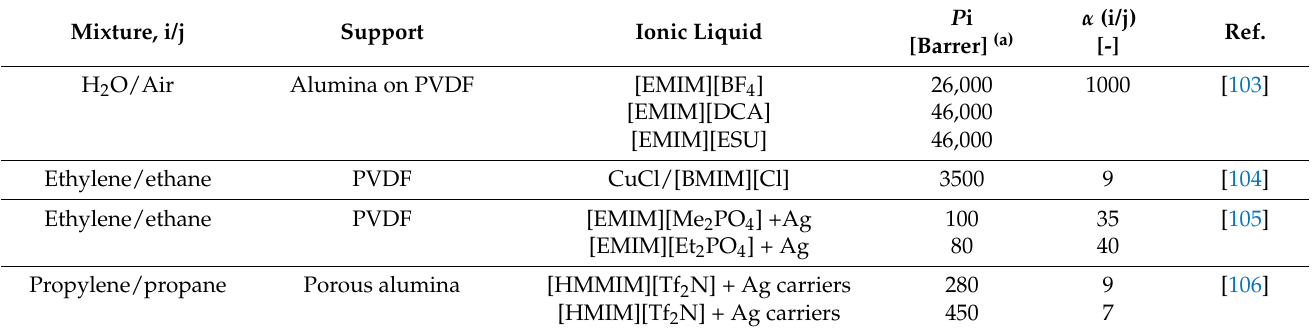
Table 4. Some recent data for supported ionic liquid membranes in volatile organic compound (VOC) separations and olefin/paraffin